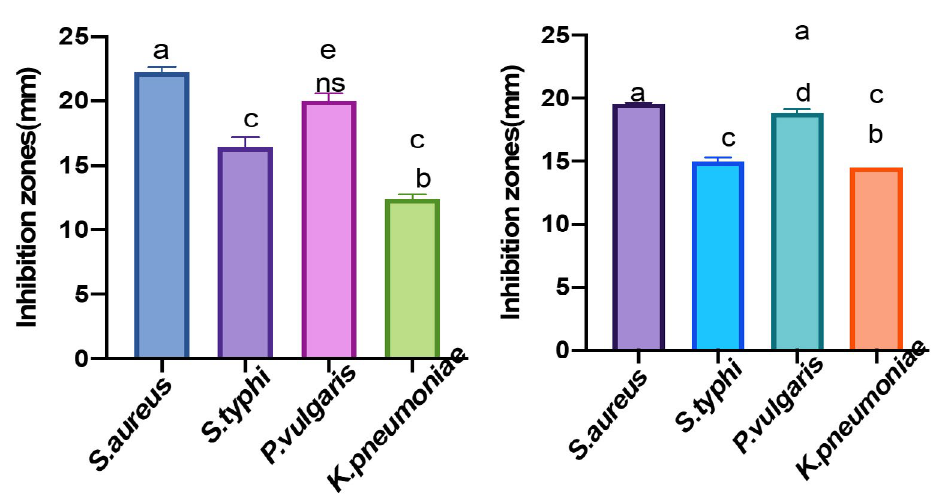
Fig. 1 & 2. Antibacterial activity of Acetone extract (Fig:1) and Methanol extract (Fig :2) of T.catappa on human pathogenic clinical isolates. Data are represented in mean ±SEM. Different letters in the bars depict the significant difference at P<0.05. Error bars signify standard error. Inhibition zones are presented in millimeter (mm).